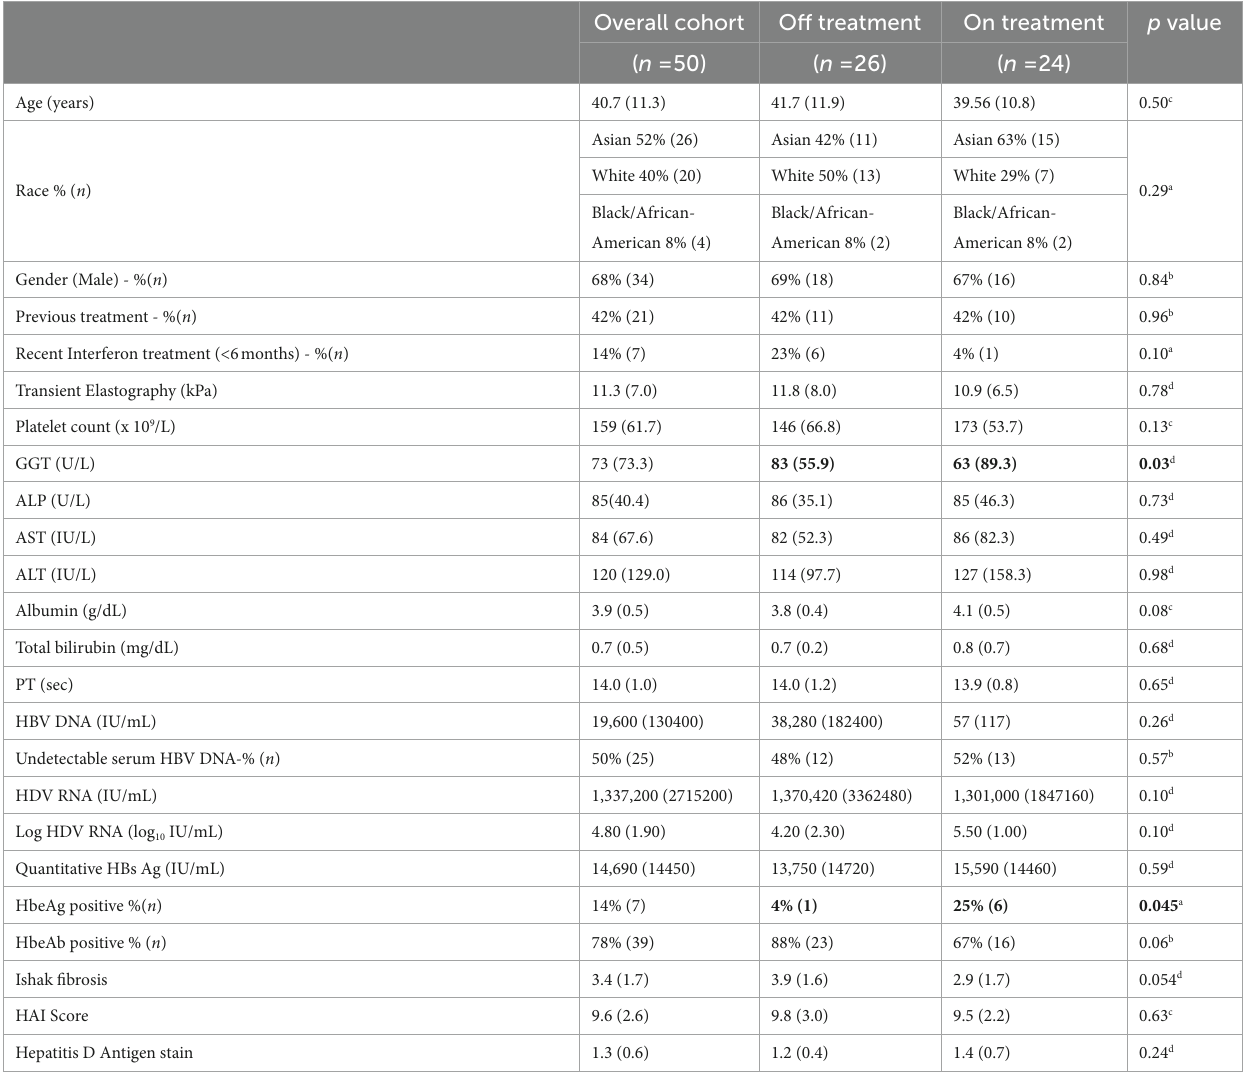
TABLE 1 Baseline characteristics of the overall cohort and stratified by treatment